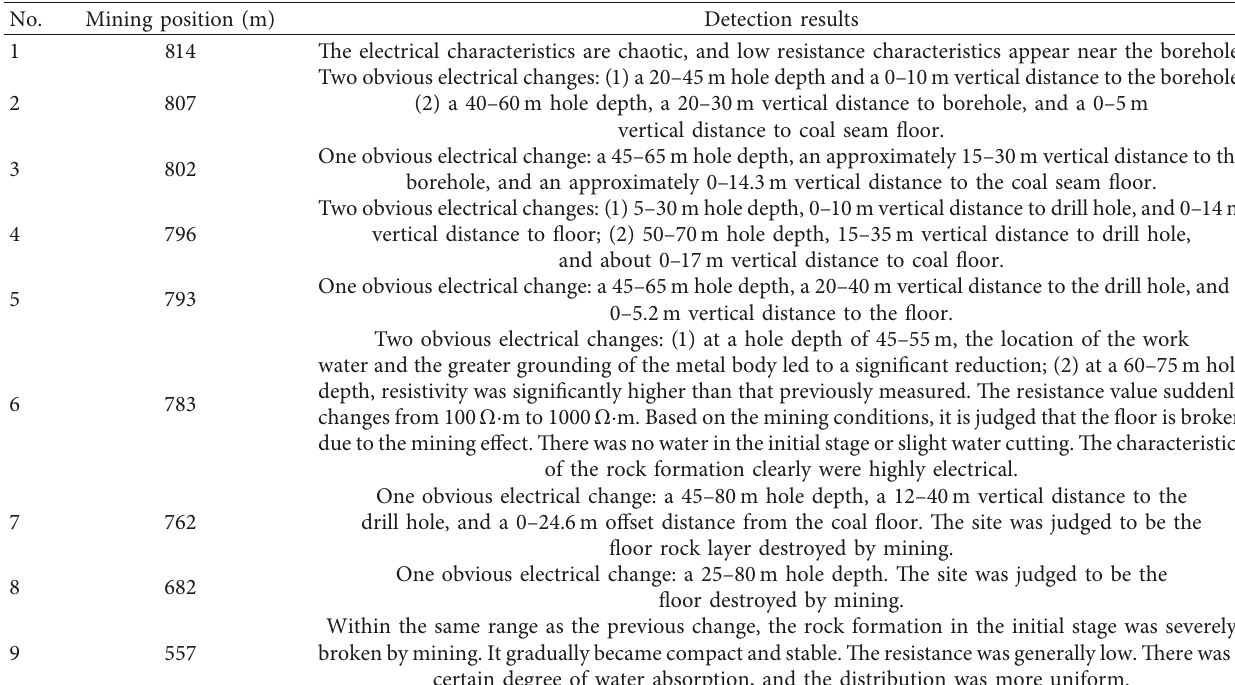
Table 1: List of detection